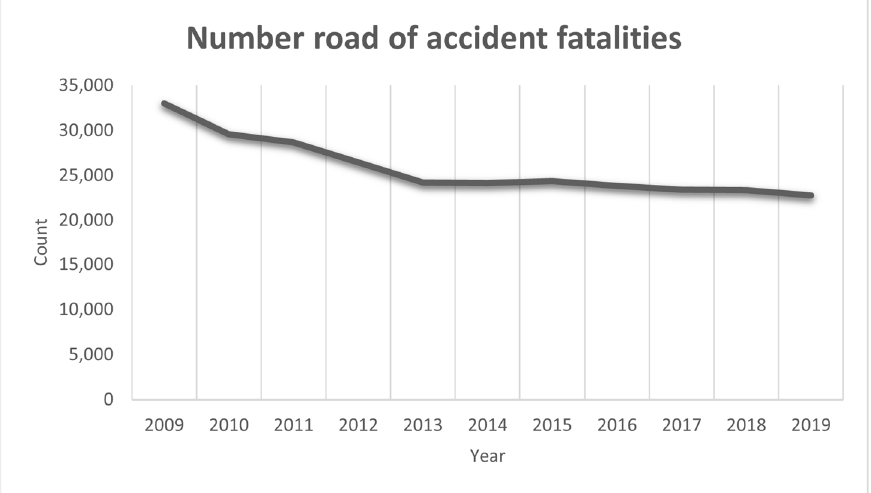
Figure 4. Number of road accident deaths in Europe based on [18].